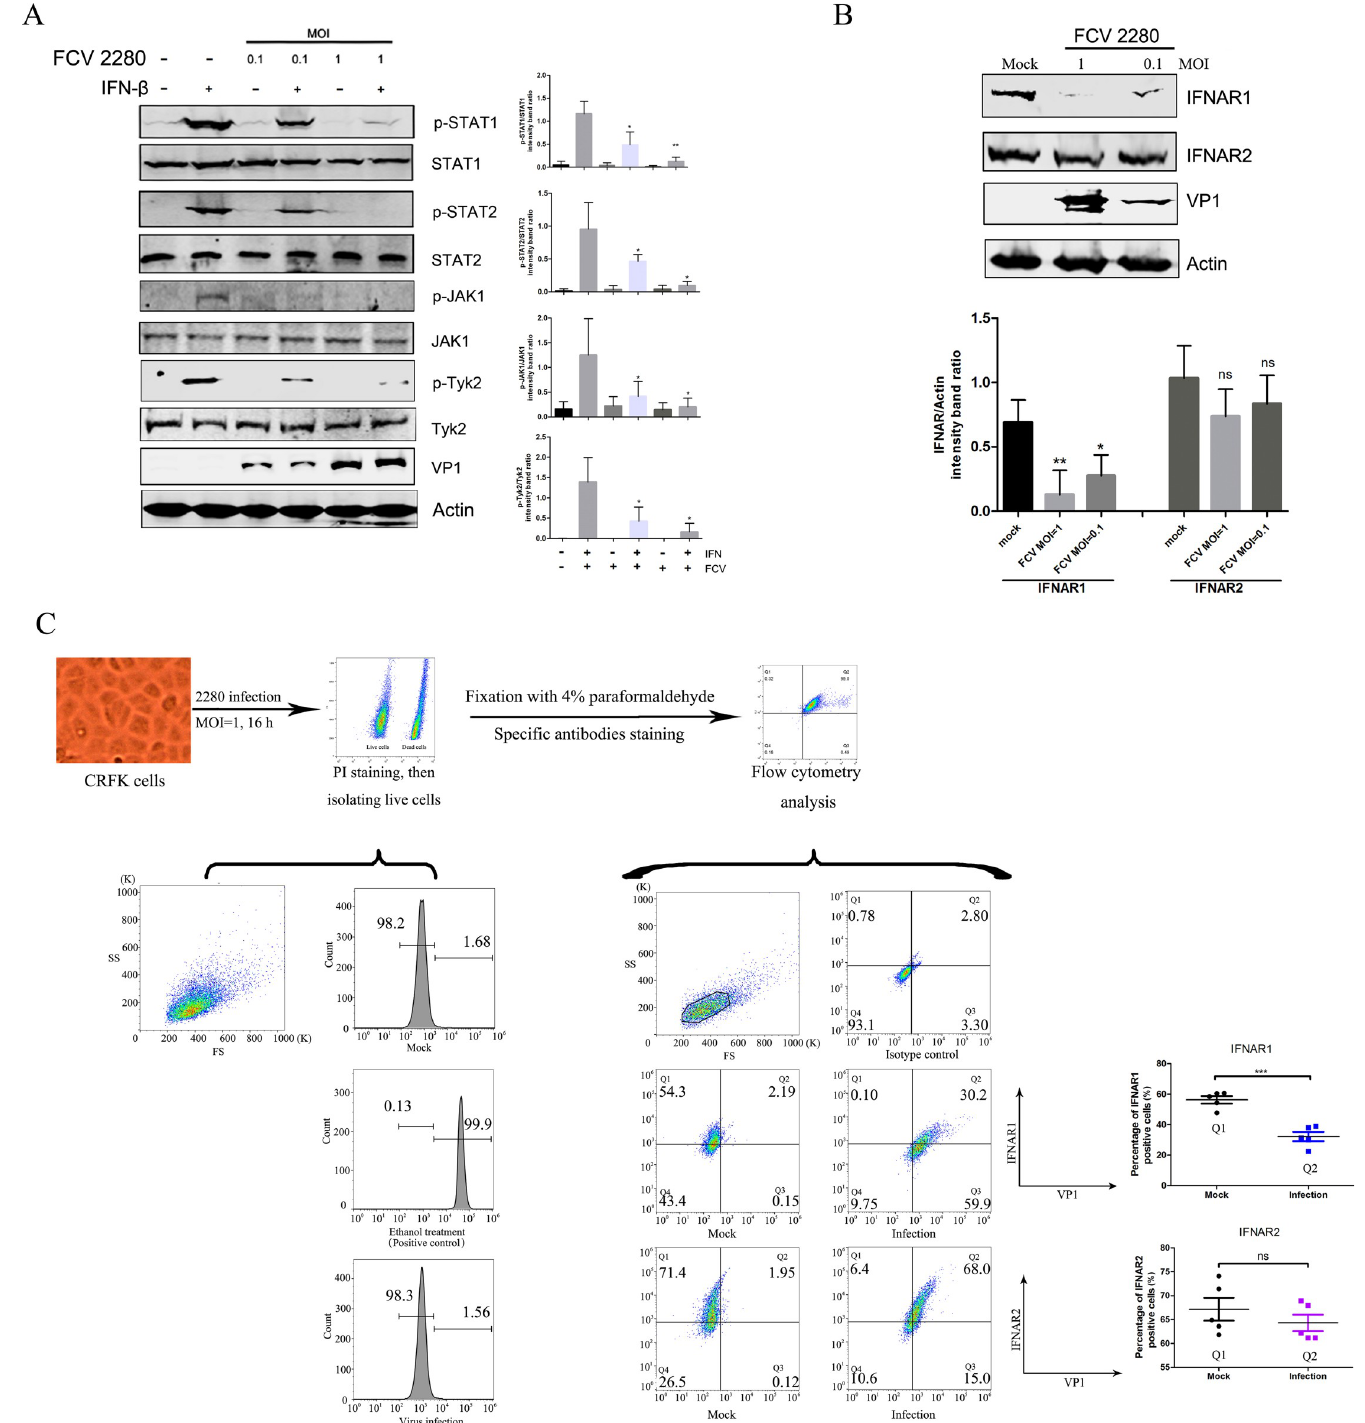
Fig 2. FCV 2280 infection reduces the expression of IFNAR1 and then inhibits the activation of STATs and JAKs. (A) CRFK cells were infected with FCV 2280 at an MOI of 0.1 or 1 for 16 h, then were treated with IFN- β (100 U/mL) for 15 min. Cells were lysed and analysed by Western blotting with antibodies against total/ phosphorylated STAT1, STAT2, JAK1, Tyk2, FCV VP1 and β -actin. (B) CRFK cells were mock infected (Mock) or infected with FCV 2280 at an MOI of 0.1 or 1 for 16 h. Cells were lysed and were analysed by WB with antibodies against IFNAR1, IFNAR2, VP1 and β -actin. (C) CRFK cells were mock infected (Mock) or infected with FCV 2280 at an MOI of 1 for 16 h, then the cells were stained using PI to isolate live cells. Ethanol treated cells acted as a positive control. After that, the cells were fixed, then the surface expression of IFNAR1 and IFNAR2 as well as viral antigen were examined with rabbit anti-IFNAR1/2 antibody or mouse anti-FCV VP1 mAb by flow